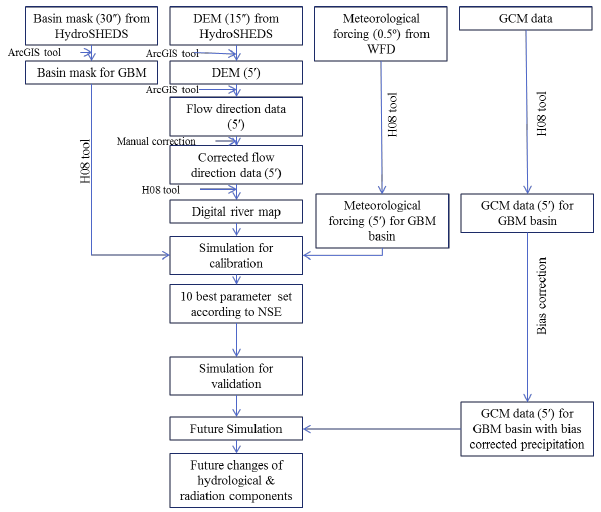
Figure 2. Flow chart of the methodology used in this